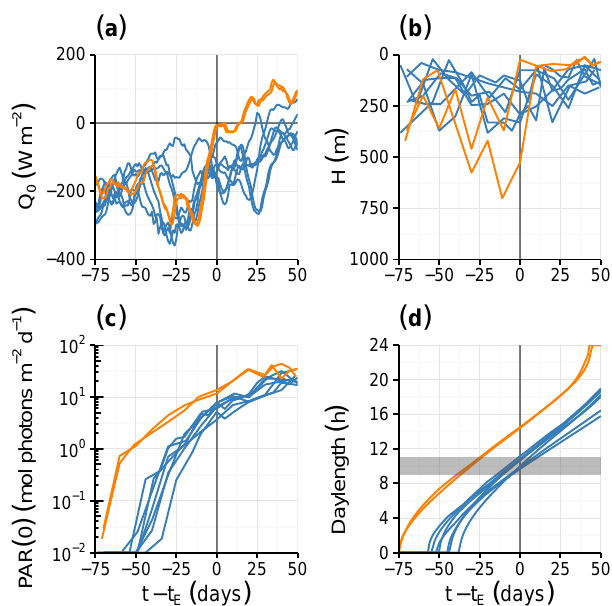
Figure 4. (a) Time series of surface heat flux ( Q 0 ) , (b) mixed layer depth ( H ), (c) the daily surface PAR corrected for cloud cover [PAR(0)], and (d) day length relative to the time of “emer- gence from signal to noise” t E for the nine bloom events observed by the floats. The gray shading indicates the critical day length range, namely 9–11h The blue lines represent the cases where the first accumulation of biomass was detected when the sea surface heat fluxes were still negative. The orange lines represent the cases where the first accumulation of biomass was detected when the win- tertime cooling shut down. A 10-day moving average has been ap- plied to Q 0 .